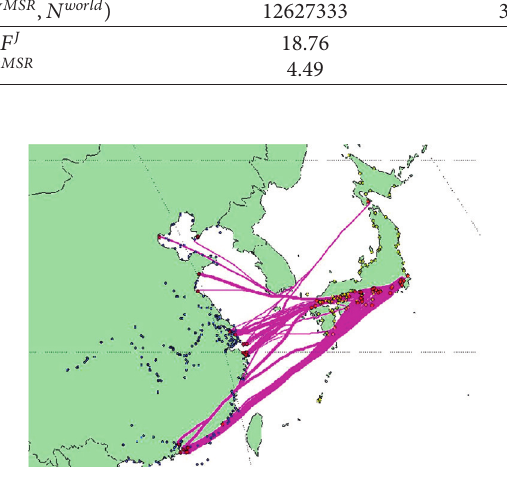
Figure 10: Primary flows between Japan and China. Table 12: Top 20 connections between Japan and China.